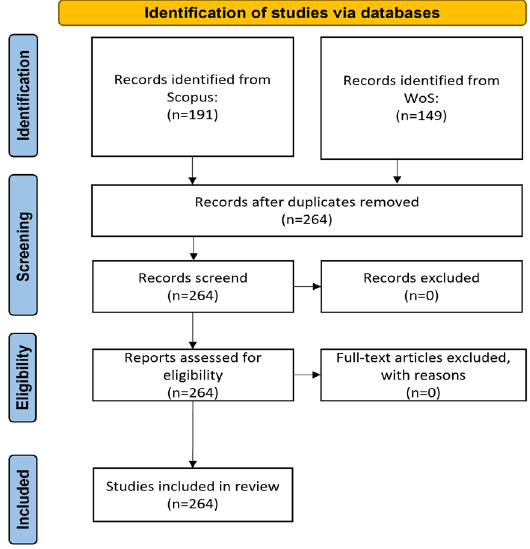
Figure 2. PRISMA Review Phases Source: Created by the authors.